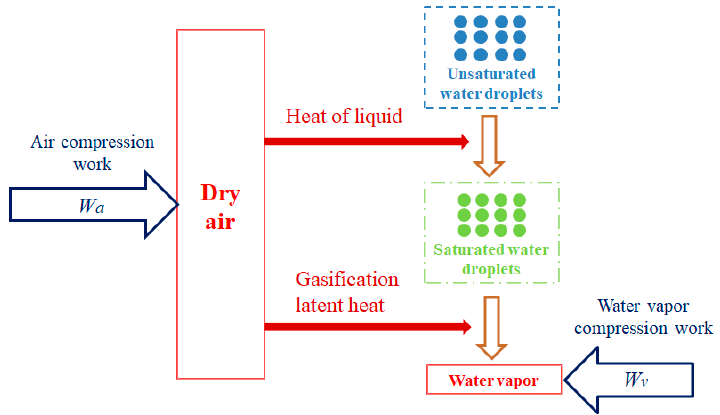
Figure 1. Heat transfer and compression work in the wet compression system.